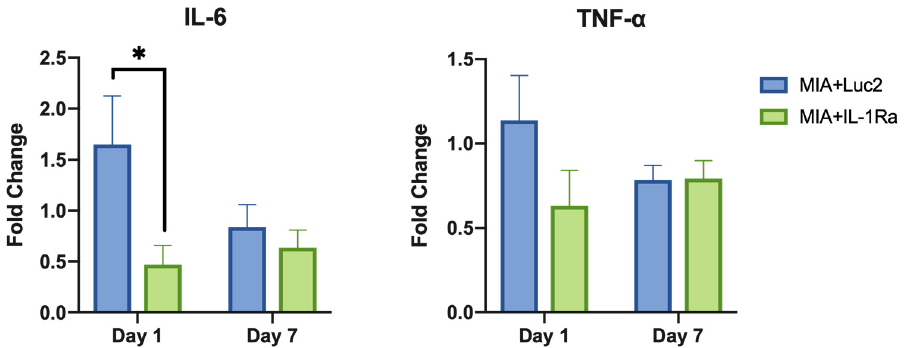
Figure 6. Suppression of inflammatory cytokines after intra-articular delivery of interleukin-1 receptor antagonist (IL-1Ra) mRNA. The expression levels of pro-inflammatory cytokines, including IL-6, and tumor necrosis factor (TNF)- α at 1 d and 7 d after the mRNA treatment. Fold change shows the relative expression compared with the expression level in healthy joints. β -actin expression was used for normalization. The expression levels of IL-6 were significantly lower in the IL-1Ra group than those in the luciferase 2 (Luc2) group on Day 1. Animal number = 6/group. * p < 0.05, analyzed by two-way ANOVA followed by Tukey’s multiple comparison